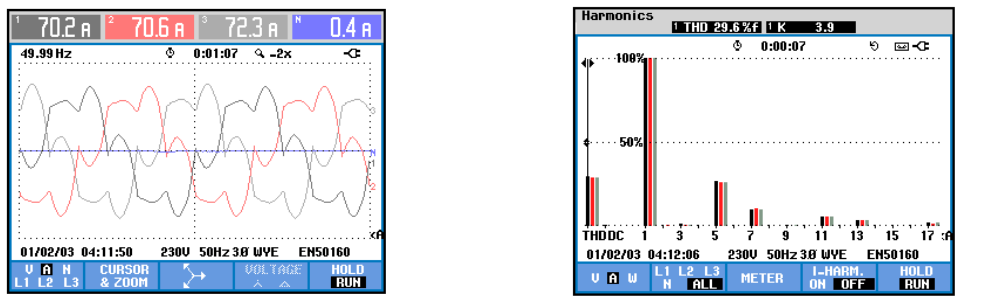
Figure 22. Waveforms of grid current and its harmonic spectra carrying active load and three-phase rectifier load without shunt APF prototype.